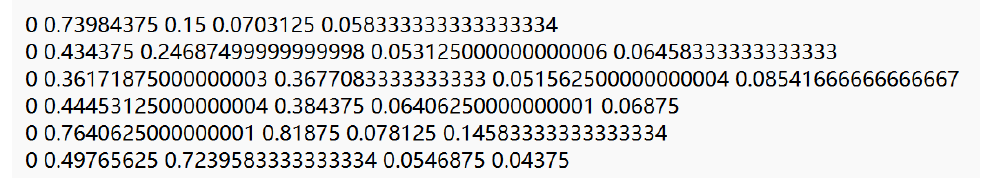
Figure 7. Annotated information.